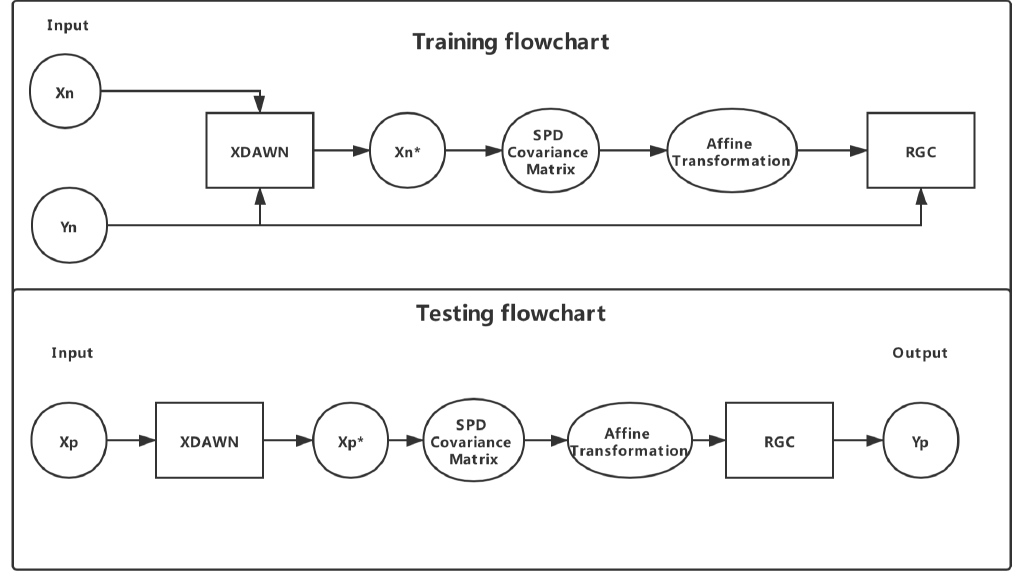
Figure 5. Flowchart of XDAWN + RGC transfer learning